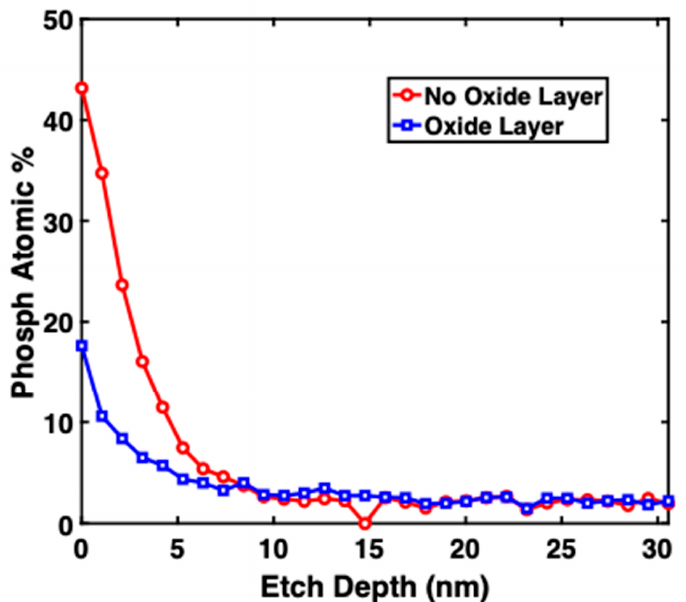
Figure 4. Atomic percentage of phosphorous in sample A (no oxide layer / legend with red circles) and sample B (oxide layer / legend with blue squares).